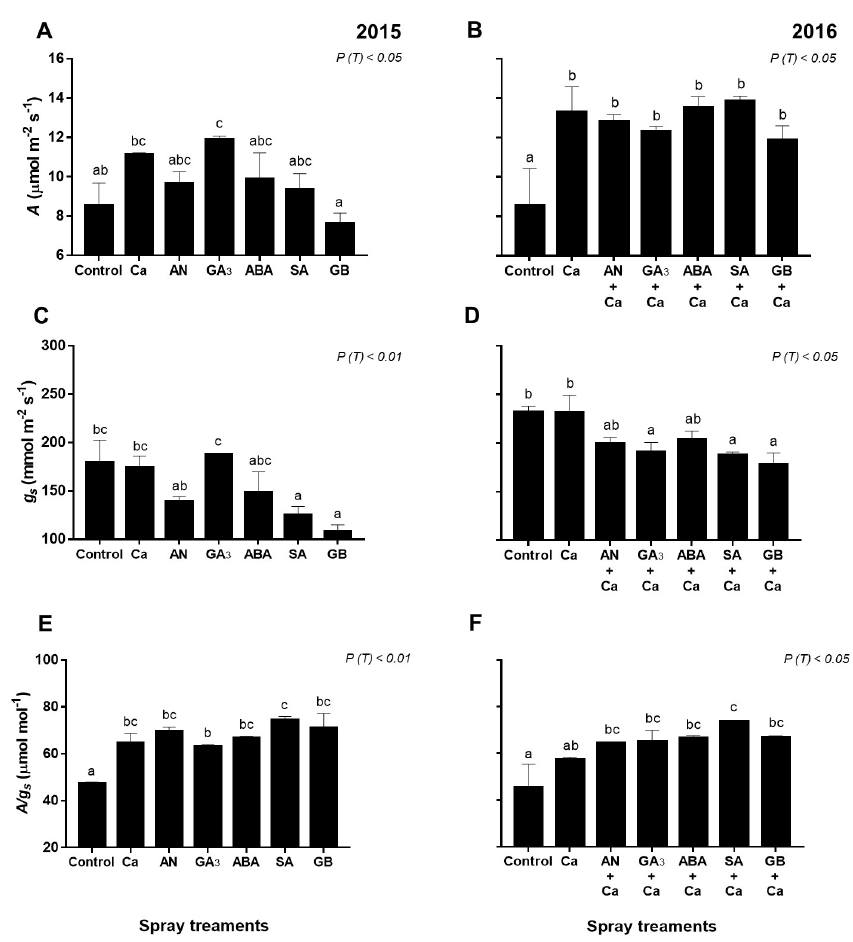
Figure 2. Net CO 2 assimilation ( A ) ( A , B ), stomatal conductance ( gs ) ( C , D ), and intrinsic water-use e ffi ciency ( A / gs ) ( E , F ) of fully exposed leaves of ‘Skeena’ cherry treated after spray treatments application in 2015–2016. Each column is expressed as mean ± SE (n = 6). Di ff erent letters indicate significant di ff erences ( P < 0.05) among treatments by Duncan’s